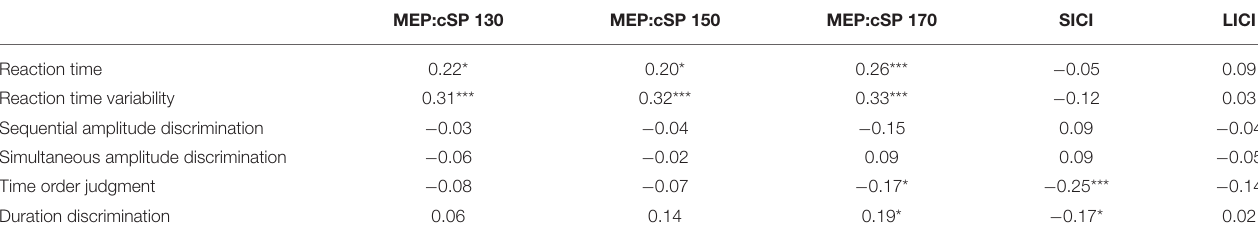
TABLE 4 | TMS and cortical metrics data from all participants who reported concussions ( n =